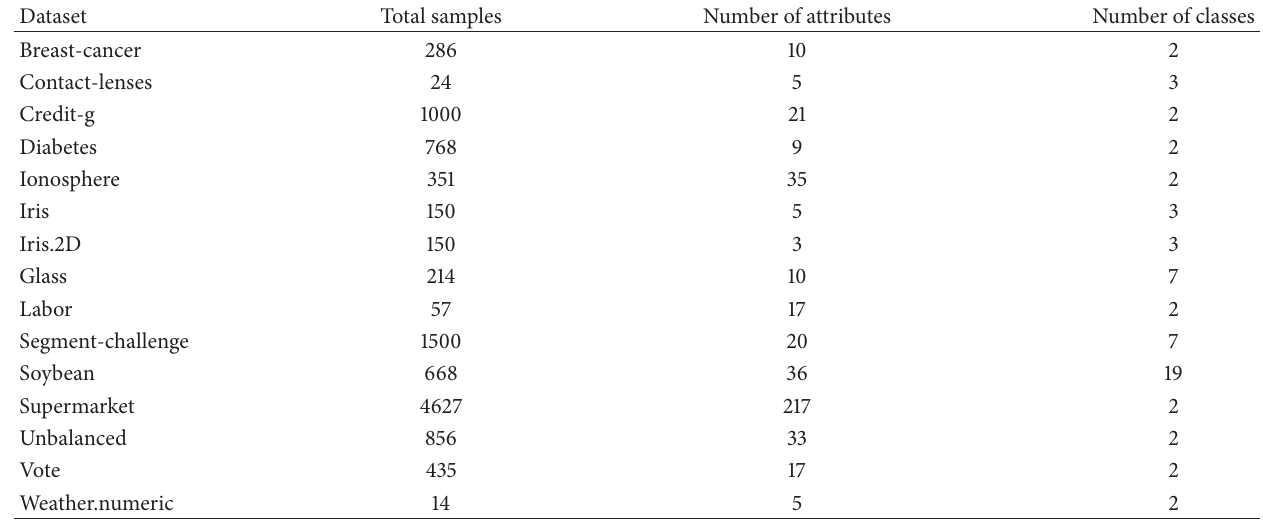
Table 1: Summary of